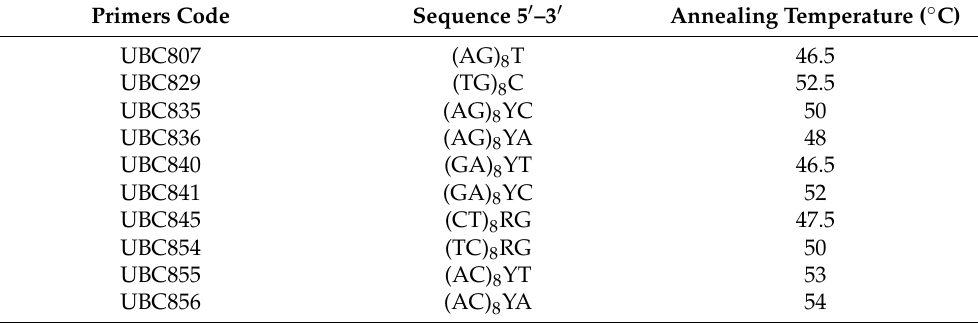
Table 1. Ten ISSR primers used in this study.